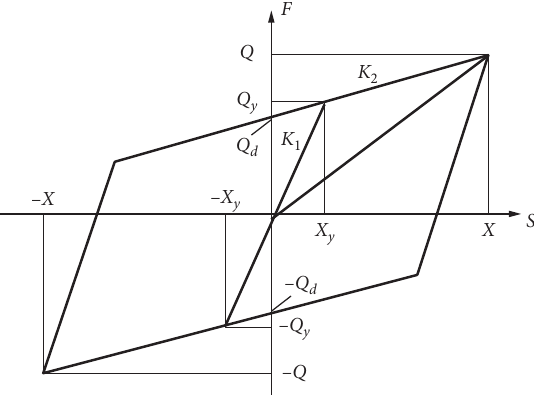
Figure 1: Equivalent bilinear restoring force model of